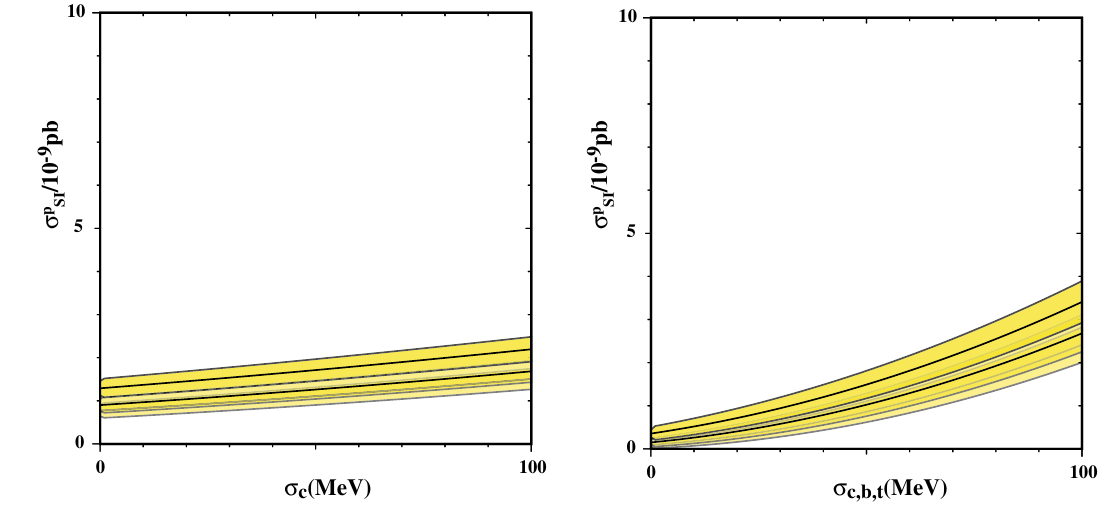
Fig. 10 Left: σ p vs σ c for fixed (cid:7) π N = 46 MeV and σ s = 30 , 50 , 100 MeV. Right: σ p SI σ = 30 , 50 , 100 MeV s